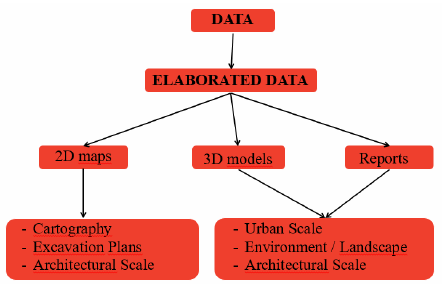
Figure 4. Elaborated data classifications .